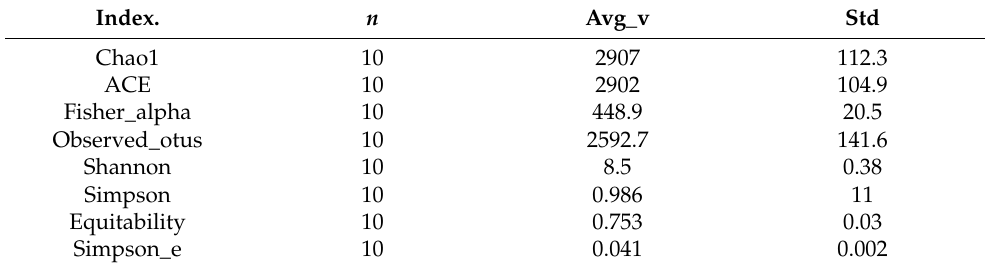
Table 5. Average alpha diversity indices (both richness and evenness) for the sheep hindgut